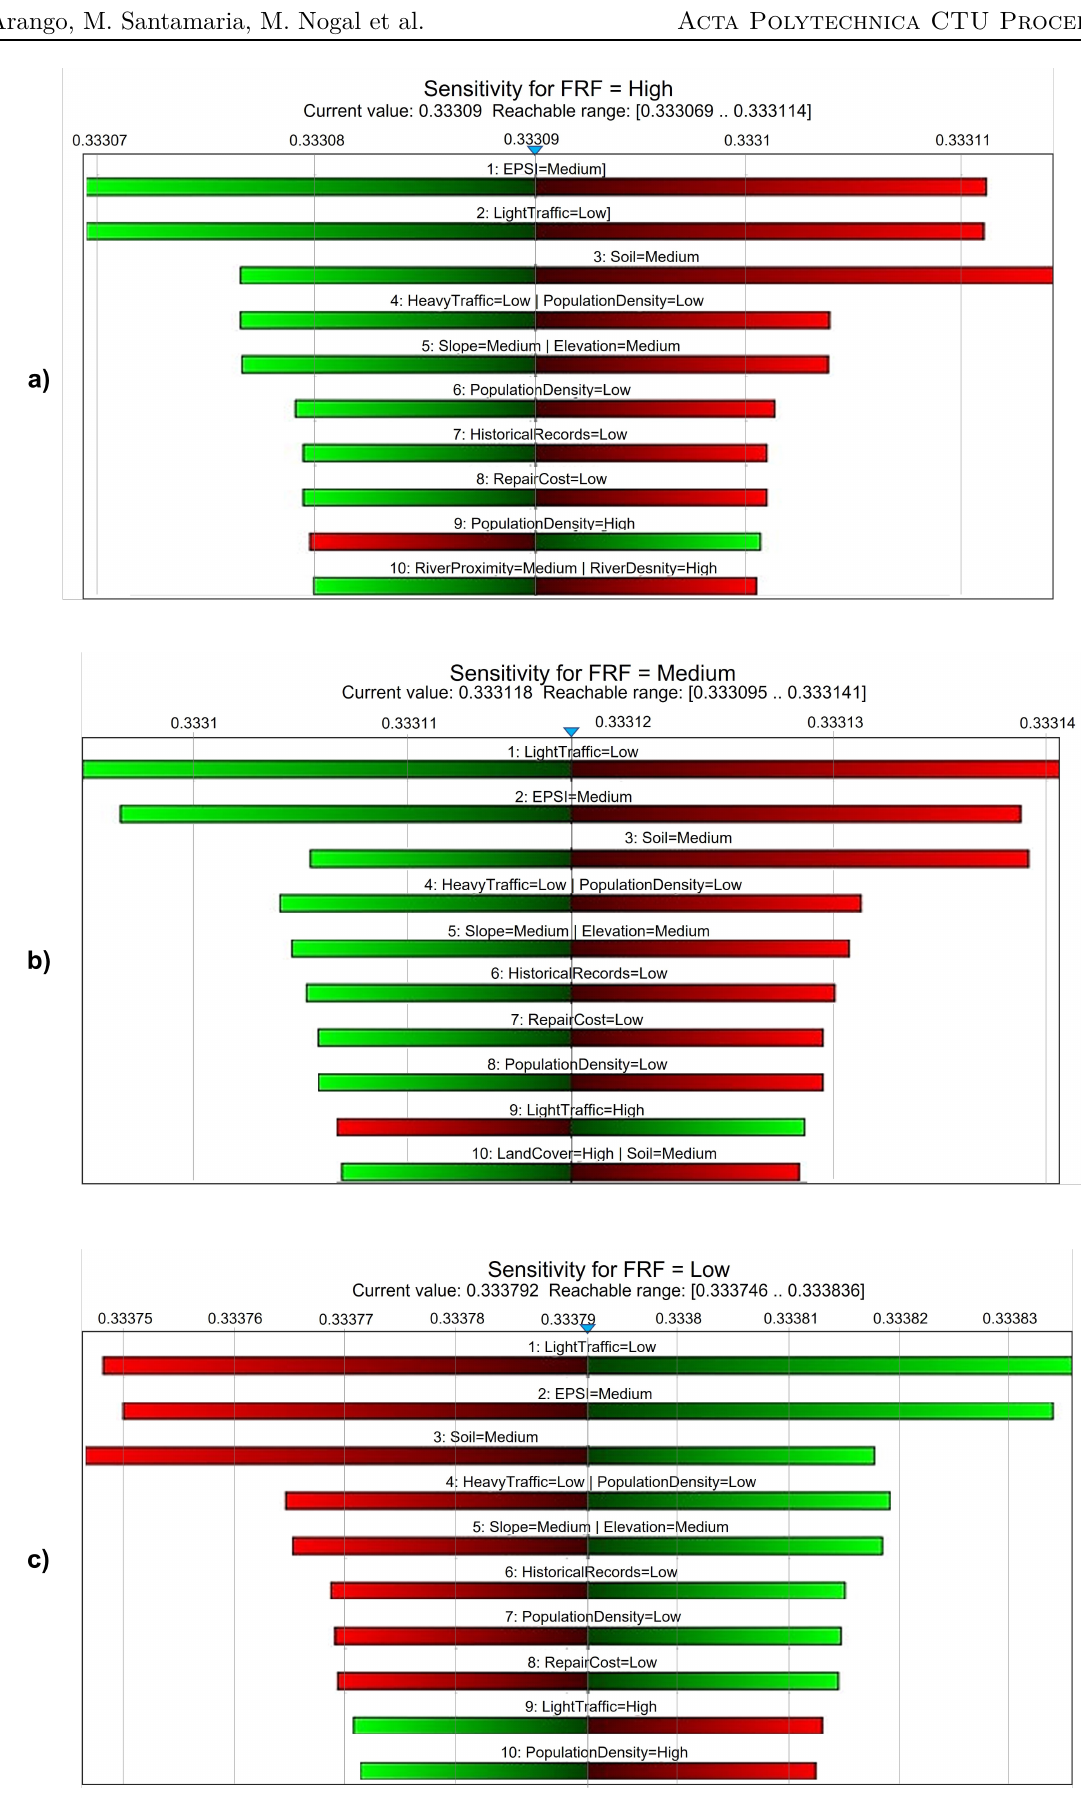
Figure 7. FRF Sensitivity Analysis: a) High, b) Medium and c)